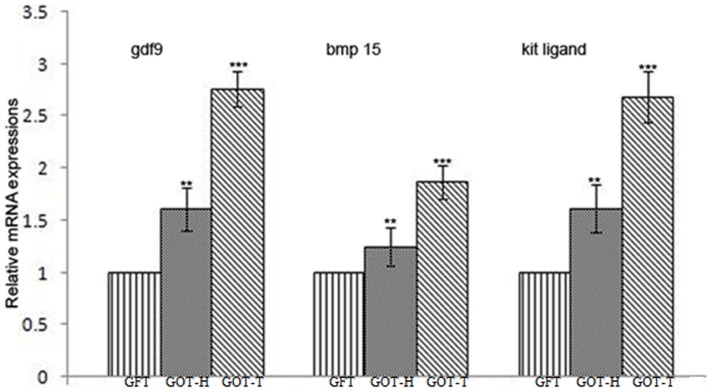
Relative mRNA expression of gdf9, bmp15 and kit ligand as assessed by real-time RT-PCR.The expression levels of gdf9, bmp15 and kit ligand are normalized with internal control, β-actin, and expressed as fold-change with respect to GFT group. The expression level of gdf9 is 1.61-fold higher in GOT-H and 2.76-fold higher in GOT-T, while the expression of bmp15 increased by 1.24-fold in GOT-H and 1.87-fold in GOT-T ovaries. The expression of kit ligand in the GOT-H and GOT-T is 1.62-fold and 2.69-fold higher, respectively. Data are presented as mean ±SEM of five independent determinations, each from individual rats of the corresponding gtoup (**p<0.05 vs. GFT; ***p<0.001 vs. GFT).